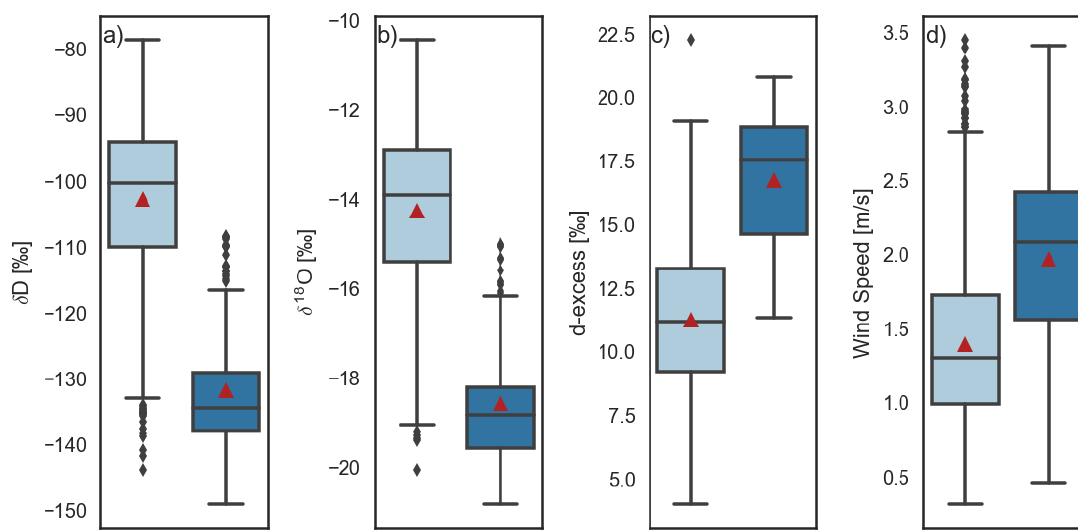
Figure 12. Observational data collected on 15 and 16 July (dark blue) relative to data collected on other days in July (light blue) for ( a ) δ D in water vapor, ( b ) δ 18 O in water vapor, ( c ) d-excess in water vapor, and ( d ) near-surface wind speed. Data were not collected on 17 July because of a power